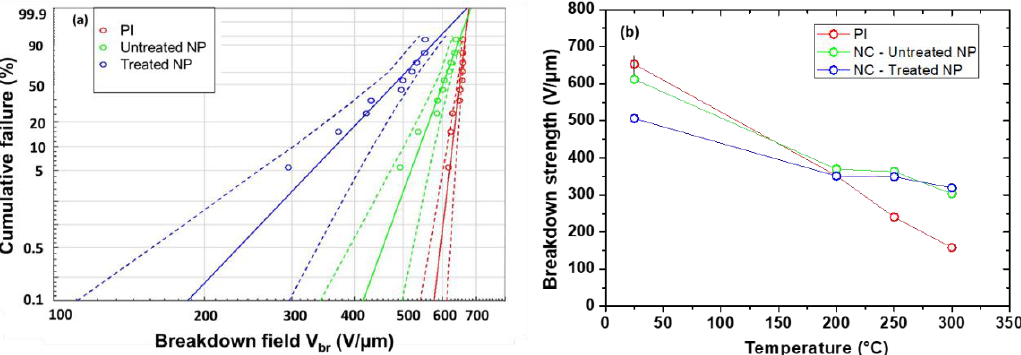
Figure 3. ( a ) Weibull statistics for breakdown results of neat PI, PI/Si 3 N 4 and PI/Si 3 N 4 -silane samples at 25 °C (dashed lines correspond to 90% confidence intervals). ( b ) Temperature dependence of breakdown strength for neat PI, PI/Si 3 N 4 , and PI/Si 3 N 4 -silane samples .